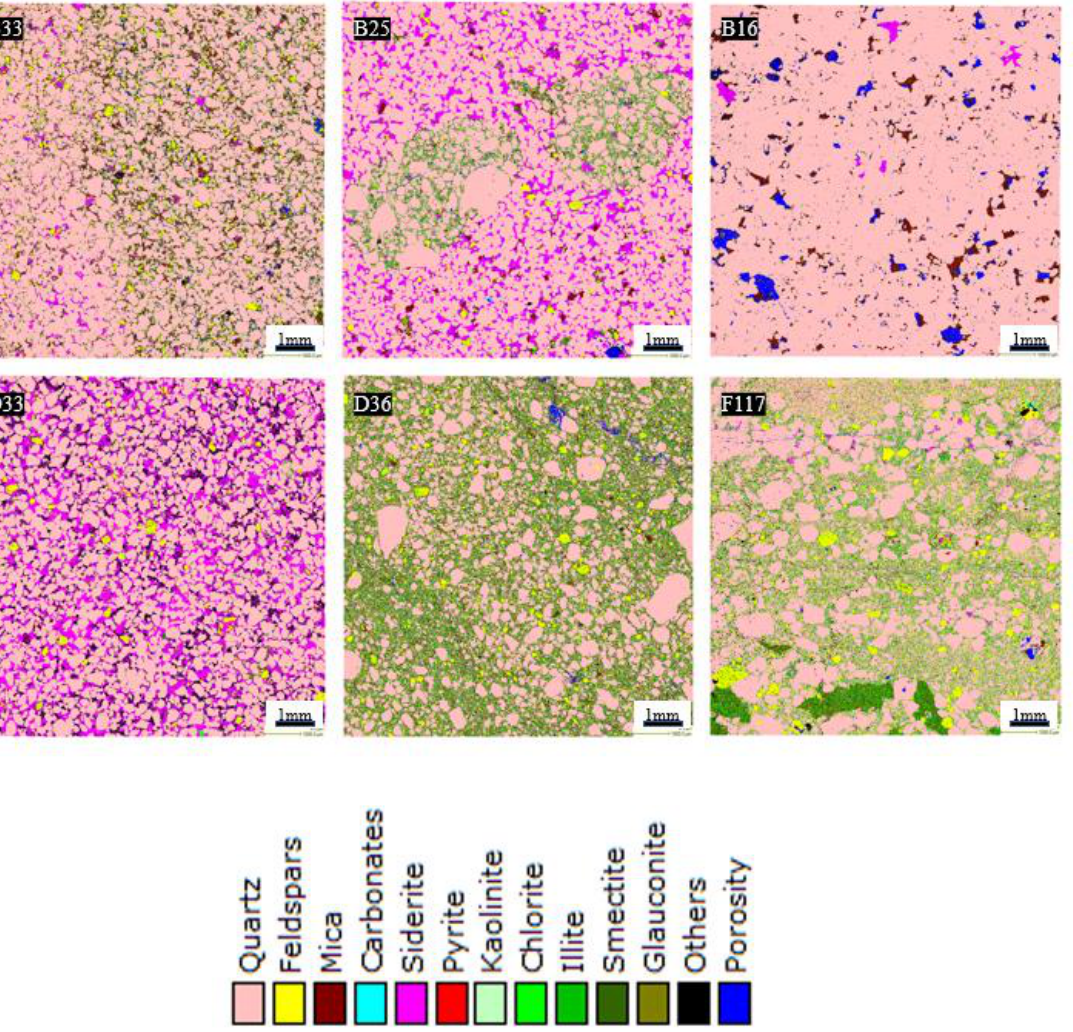
Figure 10. Quantitative evaluation of minerals by scanning electron microscope (QEMSCAN) images of samples in porosity-group 1 (<7% porosity). The color codes for different minerals and pores are shown in the legend.